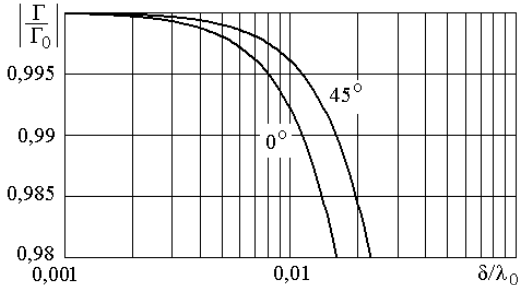
Fig. 2. Dependence of the normalized rough surface reflection coefficient on the roughness size related to the wavelength at the angle of incidence 0 and 45 о .